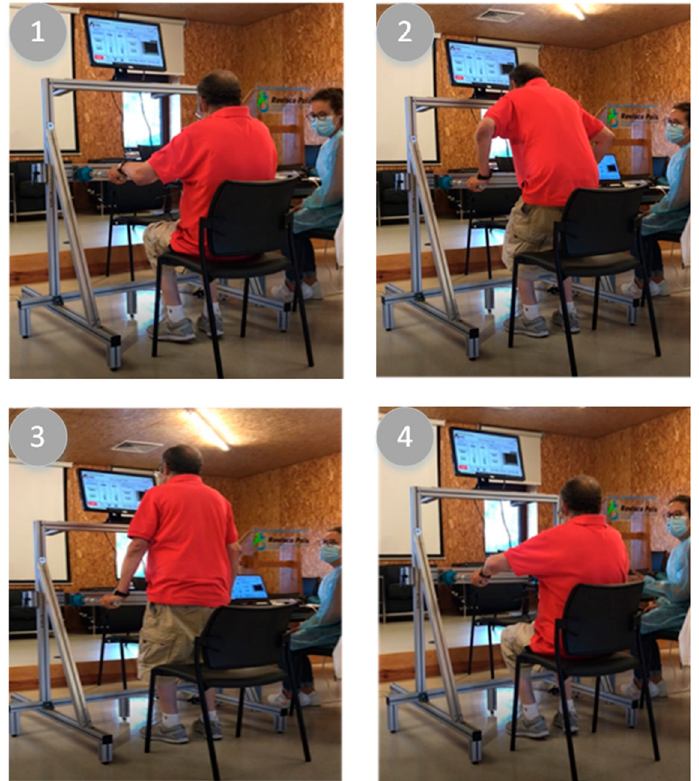
Figure 3. Example of experimental tests carried out by the volunteers from the continuing care unit: (1) Sitting; (2) Standing up; (3) Standing; (4) Sitting down. ( 1 ) Sitting; ( 2 ) Standing up; ( 3 ) Standing; ( 4 ) Sitting